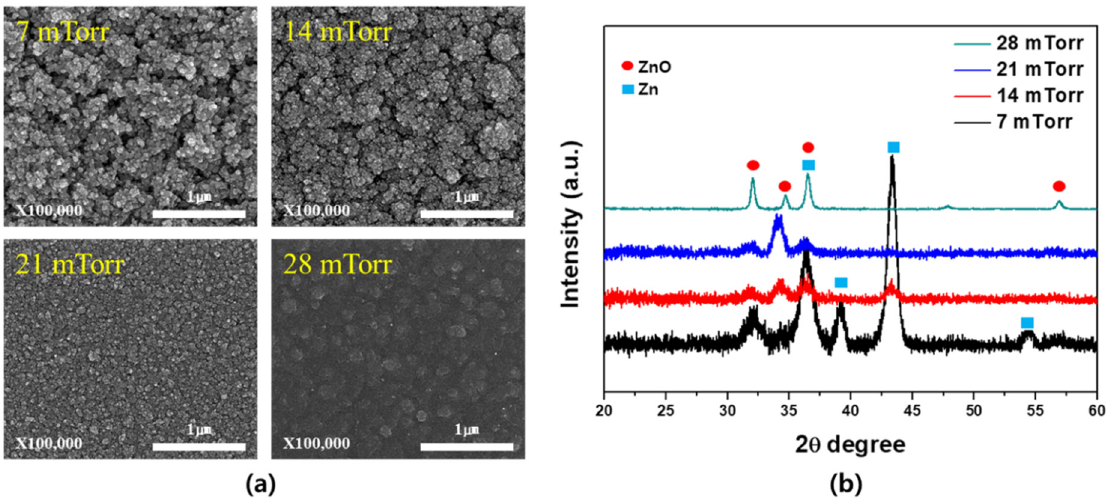
Figure 4. ( a ) Surface SEM images and ( b ) XRD patterns of the formed Zn and ZnO films upon variation in the process pressure.